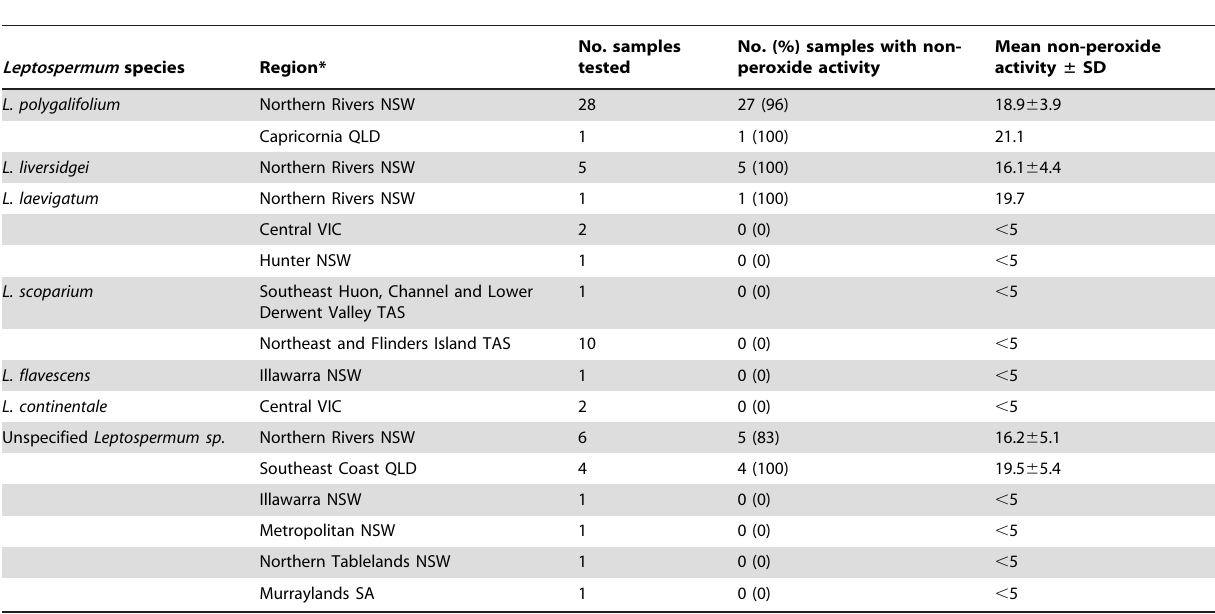
Table 3. Non-peroxide antibacterial activity and region of origin of honey derived from single Leptospermum species.